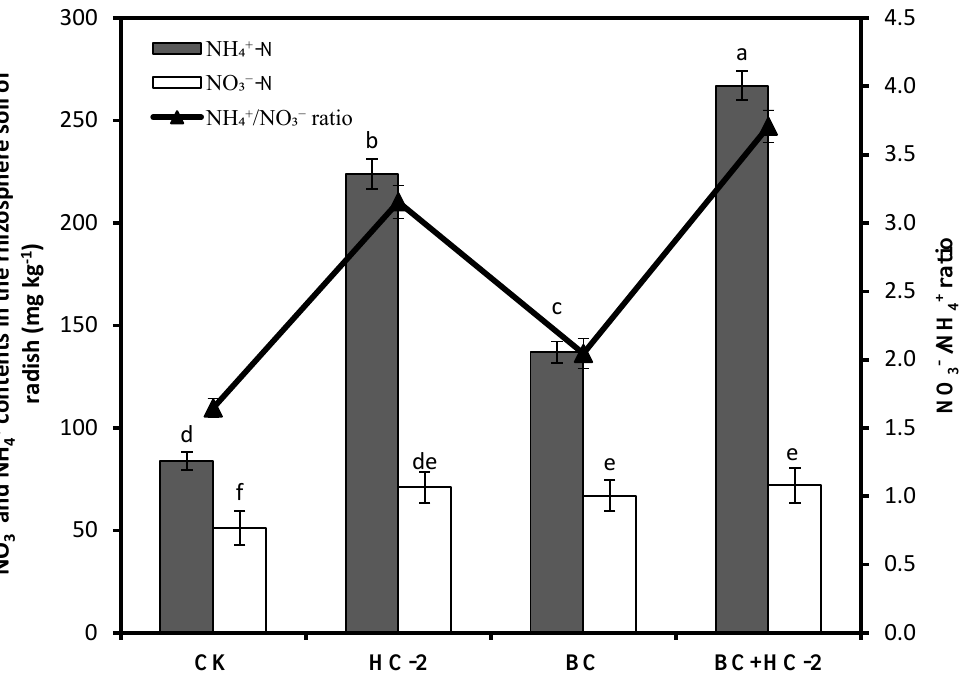
Figure 5. E ff ects of treatments of strain HC-2, BC, and BC + HC-2 on the NH 4 + -N content, NO 3 − -N Figure 5. Effects of treatments of strain HC-2, BC, and BC+HC-2 on the NH 4+ -N content, NO 3− -N content, and the NH 4 + / NO 3 − ratio in the rhizosphere soils of radish. Error bars are ± standard error ( n content, and the NH 4+/ NO 3− ratio in the rhizosphere soils of radish. Error bars are ± standard error (n + -N and NO − -N contents were significantly = 3). Bars indicated by the di ff erent letter within each NH 4 3 = 3). Bars indicated by the different letter within each NH 4+ -N and NO 3− -N contents were significantly ( p < 0.05) di ff erent according to Tukey’s test. ( p < 0.05) different according to Tukey’s test.